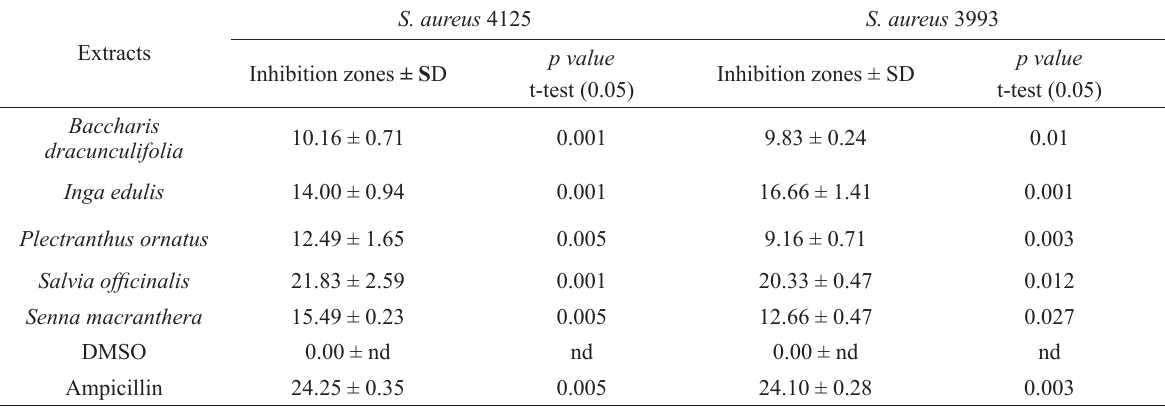
Staphylococcus aureus inhibition zones of the active extracts (mm).